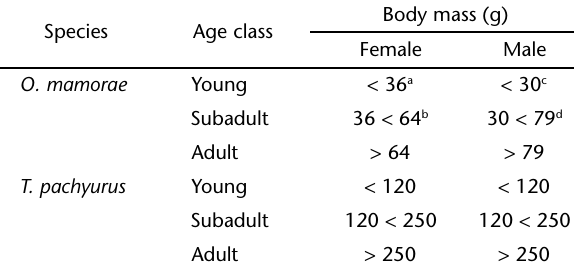
Table I. Age classes of Oecomys mamorae and Thrichomys pachyurus , estimated by body mass for each sex.